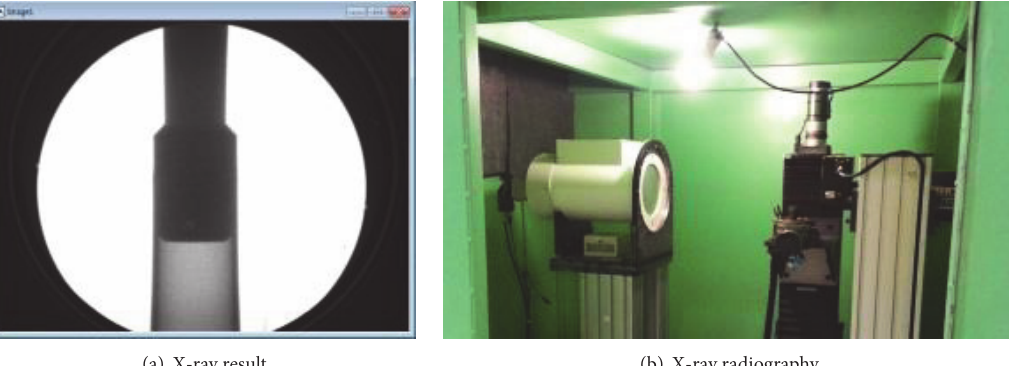
Figure 16: X-ray radiography on the weld part.